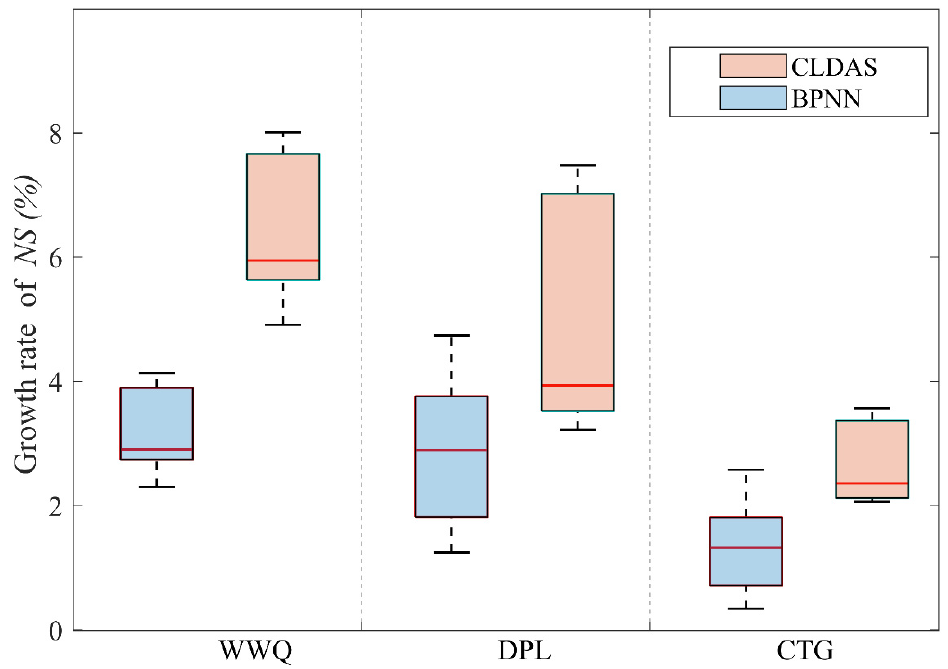
Figure 8. Boxplot of the growth rate of the NS for the three basins. 429